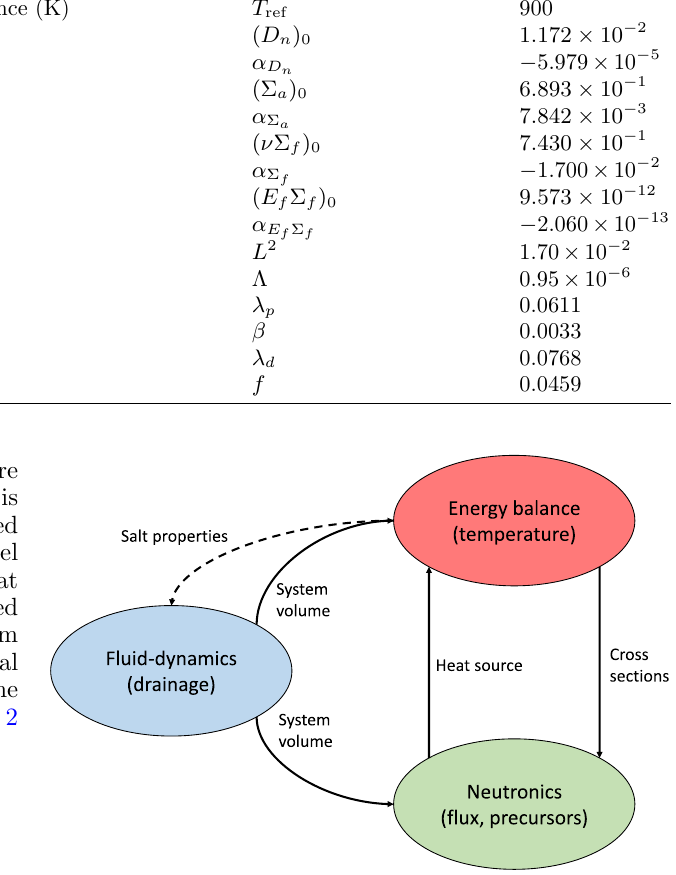
Fig. 2. Graphical scheme depicting the multiphysics interac- tion of the molten salt fuel draining phenomenon. The dashed arrow identifies the coupling between fluid-dynamics and energy balance through the temperature-dependent salt properties, currently not